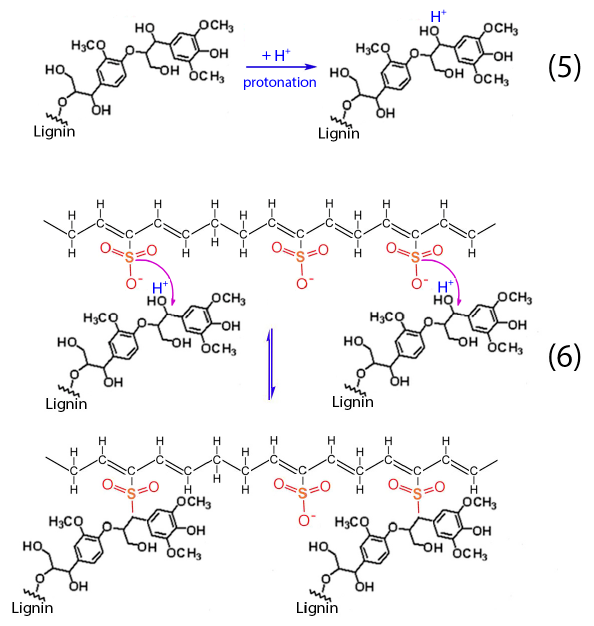
Figure 14. Chemical reactions between hydrocarbon polymers and lignin.